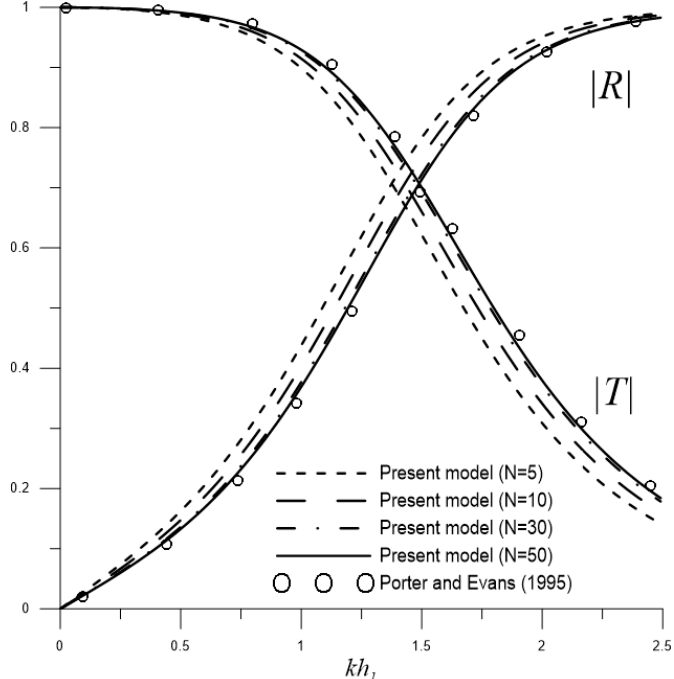
Figure 3. Reflection | R | and transmission | T | coefficients varying against kh 1 for a single surface ‐ piercing barrier over the flat bottom in normally incident waves.